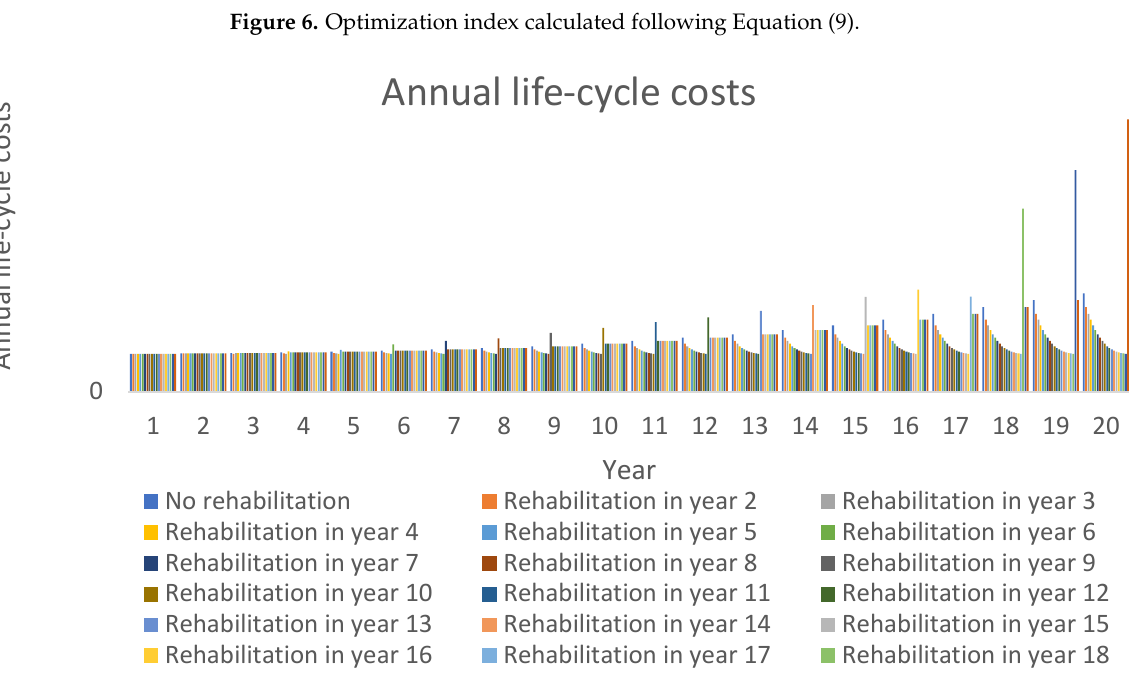
Figure 7. Annual life cycle cost — case study.